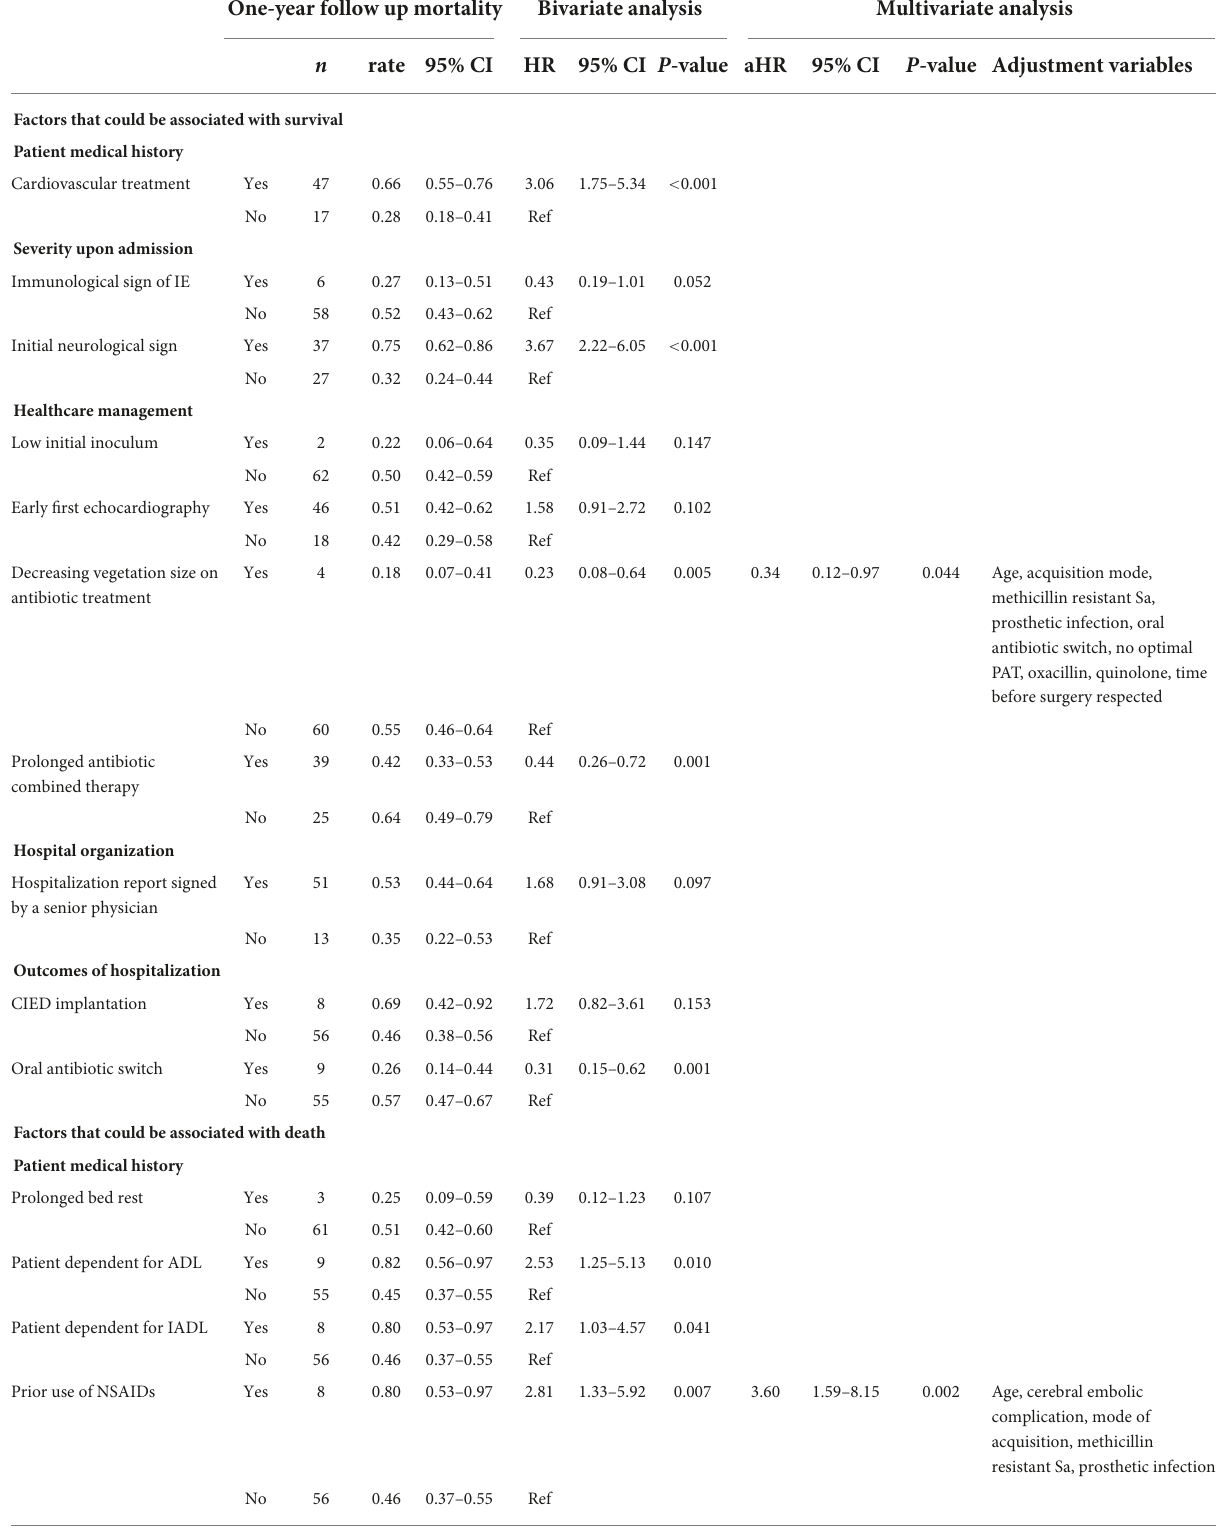
TABLE 4 Prognostic value of factors that could be associated with Staphylococcus aureus infective endocarditis outcome. One-year follow up mortality Bivariate